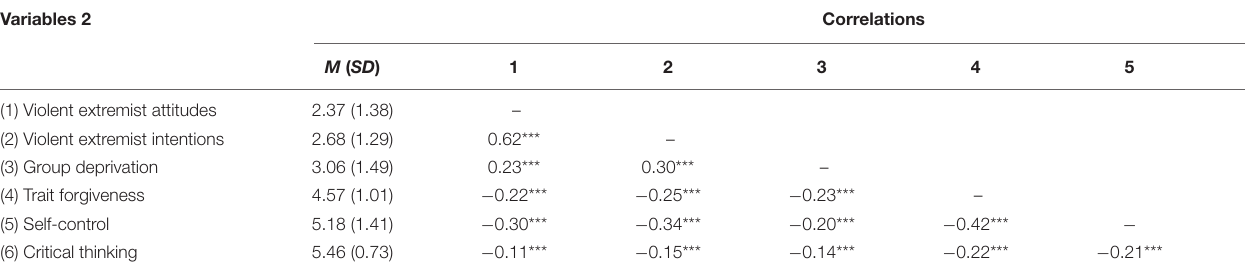
TABLE 2 | Descriptive statistics and correlations among variables of interest, Study